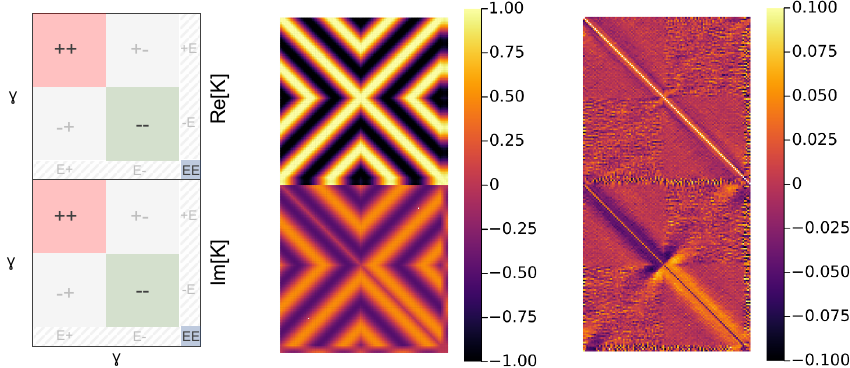
Figure 6 . (left) An explanatory sketch of our visualization of the complex kernel used in the simulations. The top major panel denotes the values of the real part and the lower major panel those of the imaginary part of the kernel. Inside each panel the values of the kernel are ordered along the contour parameter, indicating which parts of the kernel couple which range on the contour. (center) The free theory kernel in eq. (3.24), constructed explicitly in the previous section for mt The repeating pattern indicates an oscillatory behavior in coordinate space arising from the fact that this kernel is just the propagator of the free theory. (right) In the optimal learned kernel based on the low-cost update we have subtracted the unit matrix from the real-part to avoid it dominating the other structures. We find that the learned kernel exhibits some of the structure of the manually constructed kernel but in general has a more simple form, which nevertheless manages to achieve correct convergence of the complex Langevin